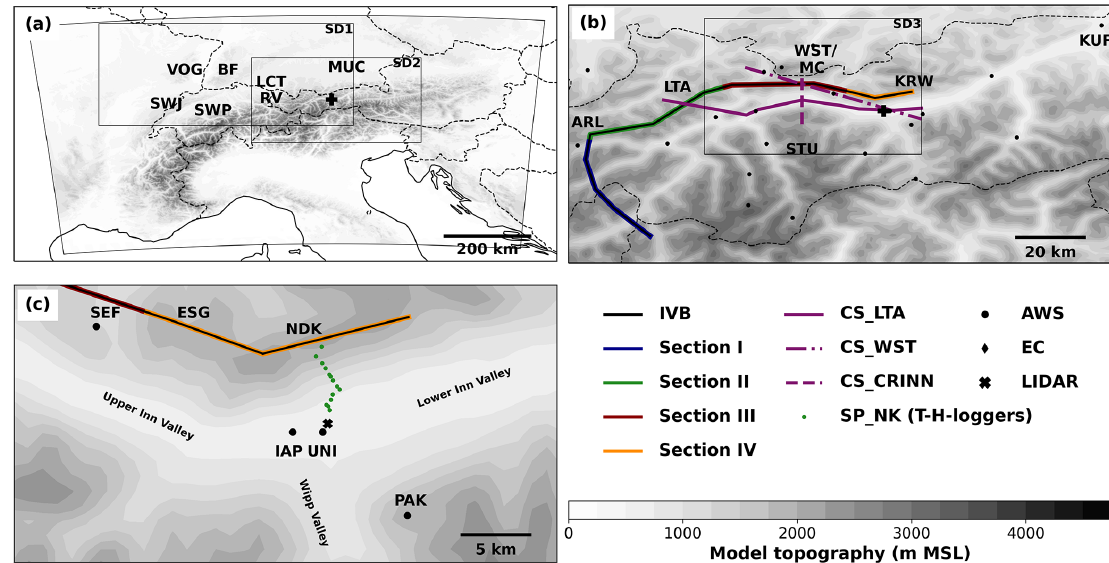
Figure 1. WRF model topography of the target area (contours, 250m increments): (a) the full model domain, (b) the Inn Valley, and (c) the region of Innsbruck. Abbreviations describe prominent locations: Swiss Jura (SWJ), Swiss Plateau (SWP), Vosges (VOG), Black Forest (BF), Lake Constance (LCT), Rhine Valley (RV), Arlberg Pass (ARL), Lechtal Alps (LTA), Wetterstein Mountains and Mieming Chain (WST/MC), Karwendel (KRW), Stubai Alps (STU), Kufstein (KUF), Seefeld (SEF), Erlspitze Group (ESG), Nordkette (NDK), Patscherkofel (PAK), and the locations of the valley-floor surface observations at Innsbruck Airport (IAP) and the University of Innsbruck (UNI). Innsbruck is marked by a black cross in (a) and (b) . The black line in (b) and (c) marks the northern boundary of the Inn Valley (IVB) represented by the crest line between ARL and KRW, as well as the western boundary of the Inn Valley south of ARL. Colored lines indicate the subsections of IVB. Three different purple lines in (b) illustrate the locations of vertical cross sections. Locations of observation sites are indicated by black symbols in (b) and (c) according to the observation type. Green dots indicate the stations of the slope profile along NDK (SP_NK). National borders are depicted as dashed black lines in (a) and (b) . Subdomains SD1, SD2, and SD3 are indicated by black rectangles in (a) and (b) . In the figures, MSL signifies above mean sea